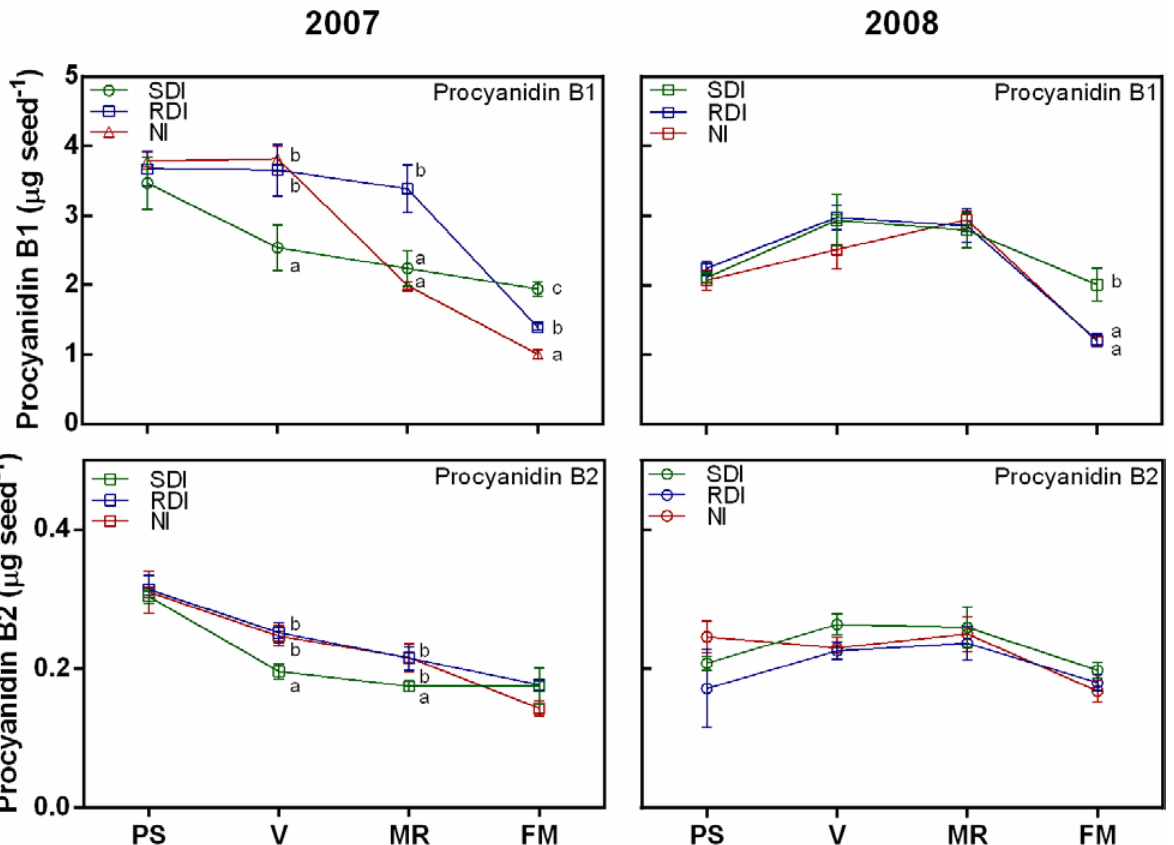
Figure 2. Changes in proanthocyanidins during ripening of grape berry seeds in SDI, RDI and NI treatments during 2007 and 2008 seasons.Values presented are means ± SE ( n ≥ 4). Different letters (a, b, c) indicate significant differences among treatments at the same date using Duncan’s test ( p ≤ 0.05). PS: end of pea size (7 weeks after anthesis); V: veraison (9 weeks after anthesis); MR: mid-ripening (11 weeks after anthesis); and FM: full maturation (13 weeks after